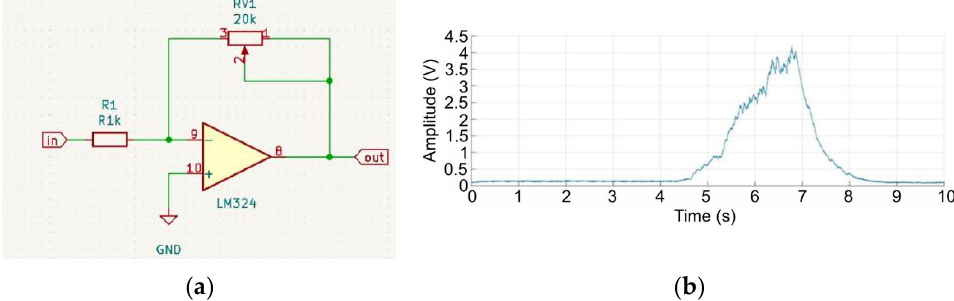
Figure 8. Connection diagram of one of the LM324 operational amplifier circuits in an inverting amplifier configuration with adjustable gain ( a ), time and frequency diagram of the signal after low-pass filtering ( b